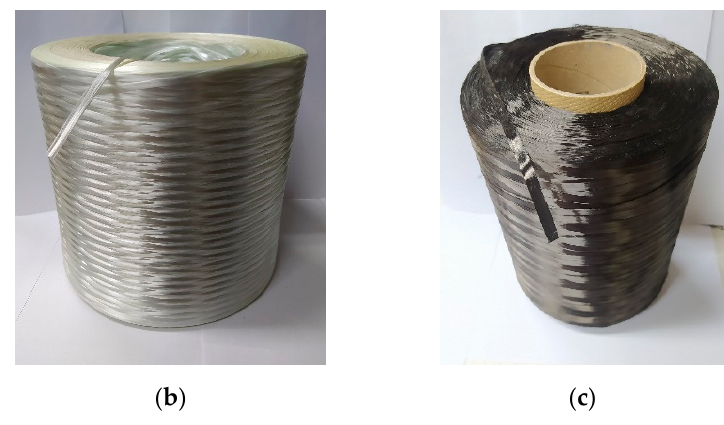
Figure 2. Long fiber (roving): ( a ) aramid fiber; ( b ) glass fiber; ( c ) carbon fibre.